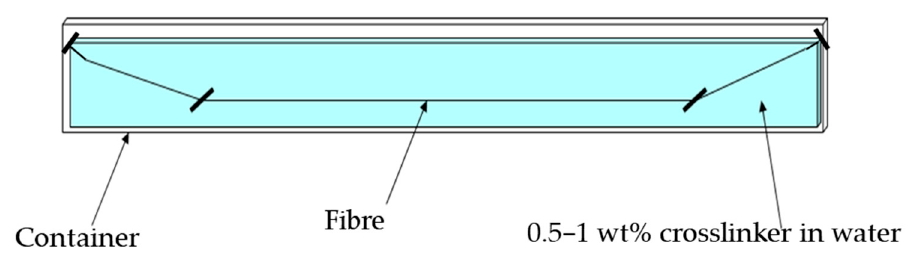
Figure 2. Schematic representation of TcC/PA1010 filaments immersed in aqueous solutions of cross-linkers.